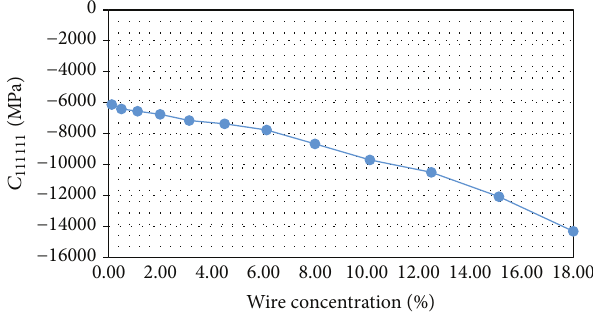
(1) 𝐶 111111 for reinforced plexiglas